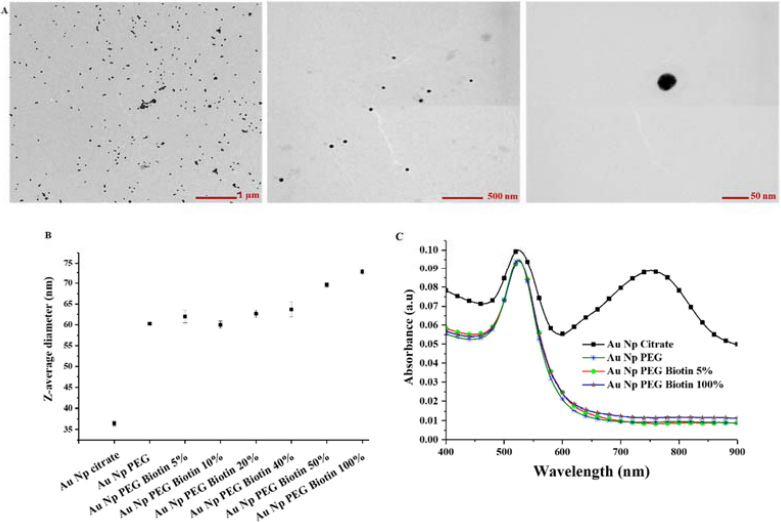
Figure 2. Characterization of as ‐ synthesized and PEG ‐ grafted gold nanoparticles. ( A ) Transmission electron micrographs of as ‐ synthesized and citrate stabilized 40 ‐ nm gold nanoparticles; ( B ) hydrodynamic size of gold nanoparticles measured by dynamic light scattering. The nanoparticles are functionalized by a PEG polymer brush containing different fractions of PEG with biotin end ‐ group functionality; ( C ) UV ‐ Vis extinction spectra for as ‐ synthesized and PEG ‐ grafted Au NPs showing deaggregation in physiological saline (145.4 M NaCl) to individually stabilized Au NPs after PEG ‐ grafting.